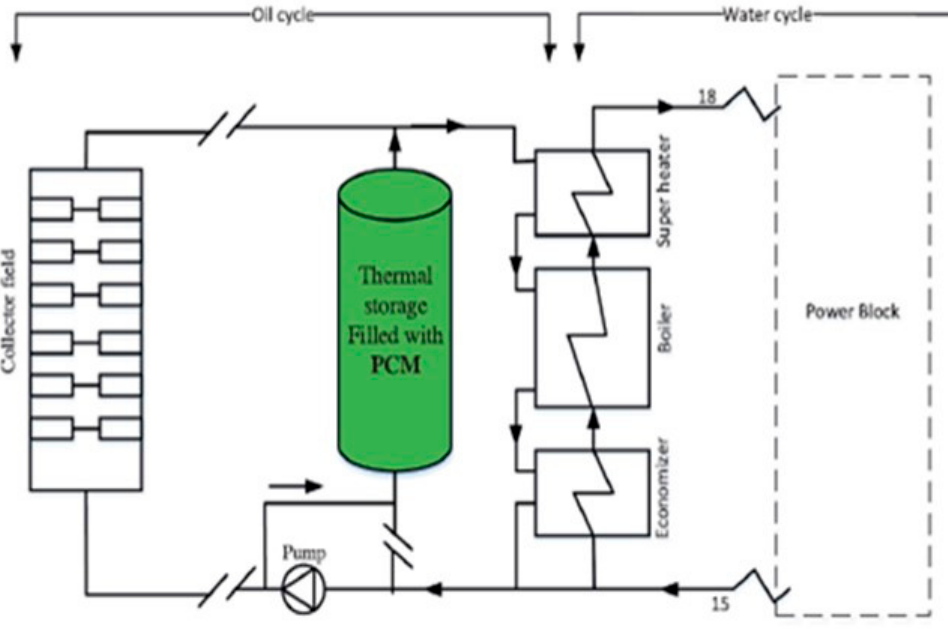
Figure 5. Schematic diagram of the PCM collector arrangement (Marhfuz et al. [53]). The exergy efficiency was calculated as exergy recovered from the PCM ( X o.pcm )